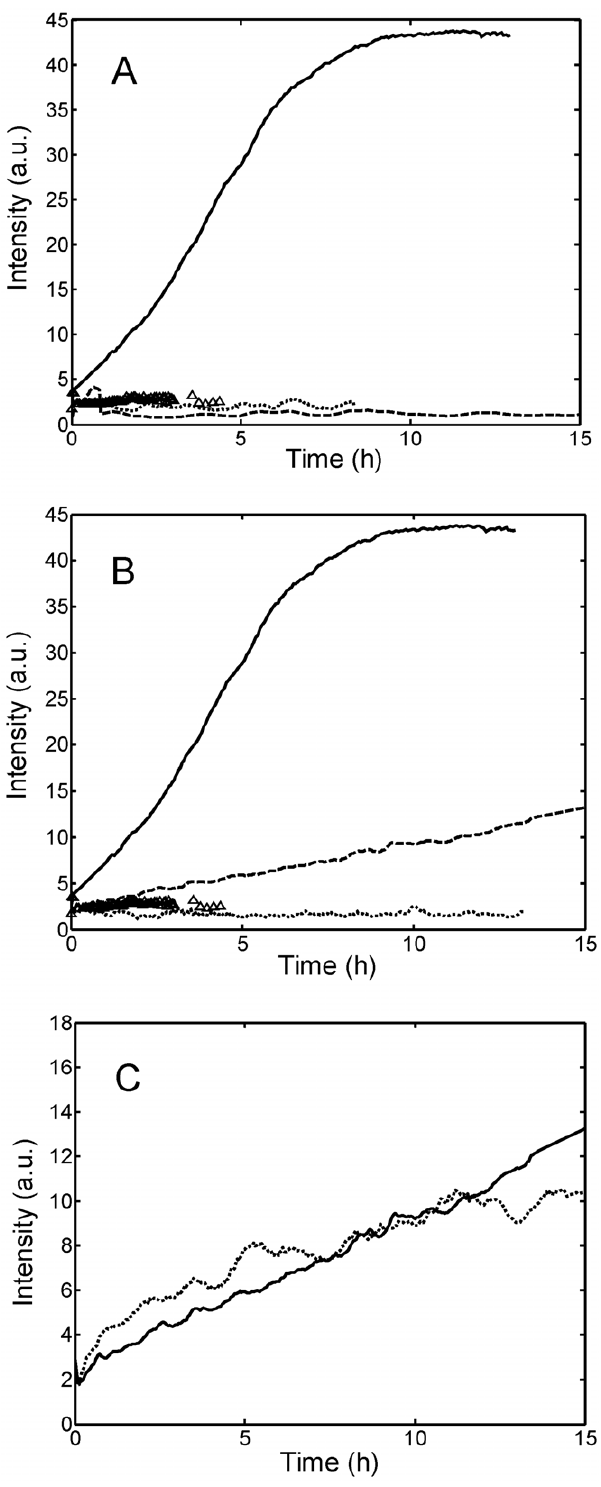
Figure 3. Light scattering intensities measured on-line by insitu DLS. (A) 1 g/L light chain solution in 20 mM HCl buffer at pH 2.0 without salt ( n ), with 0.15 M NaCl (–), NaH 2 PO 4 (...), Na 2 SO 4 (_) (runs 3, 4, 6 and 9 in Table 1); (B) The same as (A) but salts are compared at similar ionic strength (see text): 0.45 M NaCl (–), 0.49 M NaH 2 PO 4 (...), 0.15 M Na 2 SO 4 (_) (runs 4, 6 and 8 in Table 1); (C) The same as (A) but for a solution in 20 mM HCl buffer at pH 2.0, with 0.45 M NaCl (_) and KCl (...) (runs 4 and 10 in Table 1).